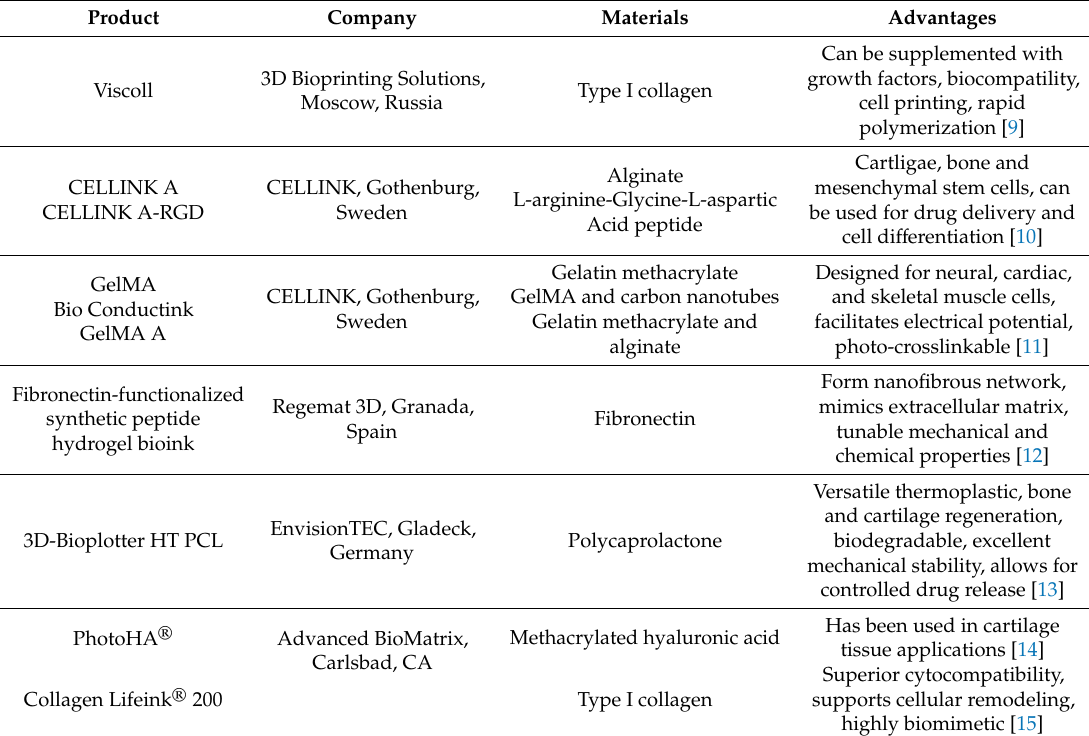
Table 1. Commercially available